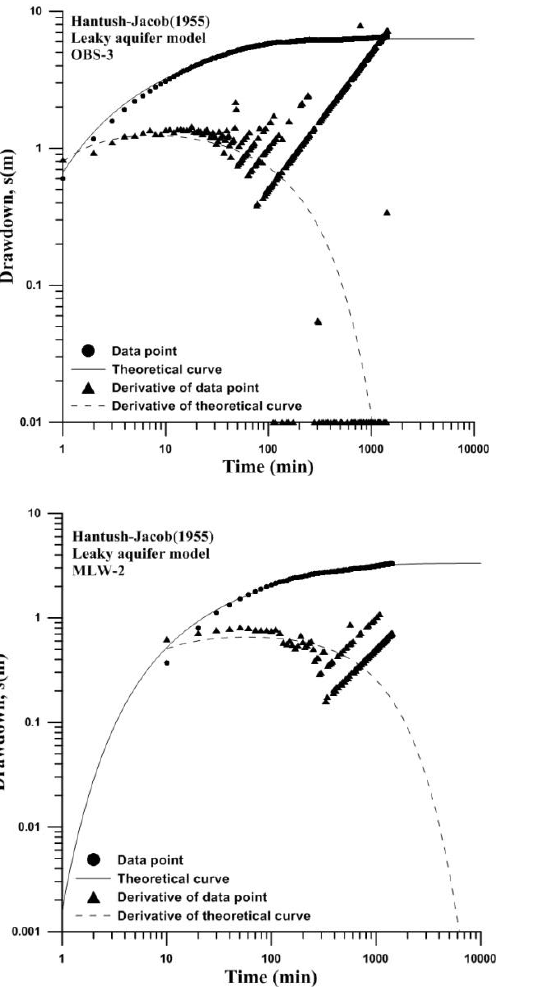
Figure 6. Hantush–Jacob (1955) leaky aquifer model of pumping tests at the OBS-3, MLW-1, MLW-2, MLW-3, and OBS-5 observation wells. Transmissivity ( T ) estimates ranged from 1.14 × 10 -4 to 5.52 × 10 -4 m 2 /s and storativity ( S ) estimates ranged from 1.5 × 10 -5 – 1.1 × 10 -2 using the leaky aquifer model [22]. The T values via the Cooper–Jacob unconfined model ranged from 4.67 × 10 -3 to 4.76 × 10 -3 m 2 /s and the S values ranged from 0.25 to 2.26 m, whereas the T values using the Newman unconfined model were determined as 1.91 × 10 -3 –4.19×10 -3 m 2 /s